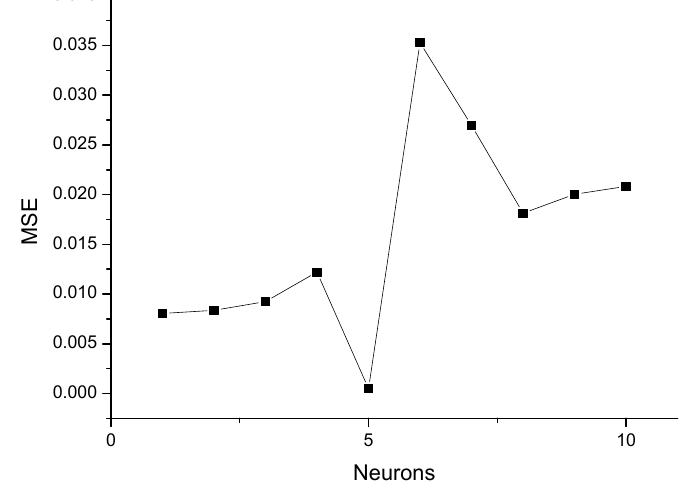
Figure 17. Correlation between MSE and the number of hidden neurons.